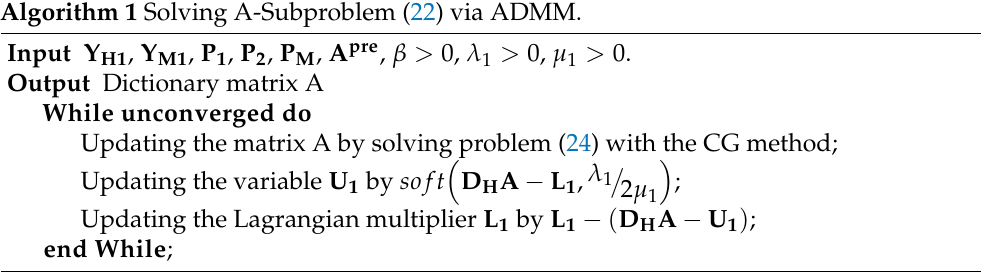
Algorithm 1 Solving A-Subproblem (22) via